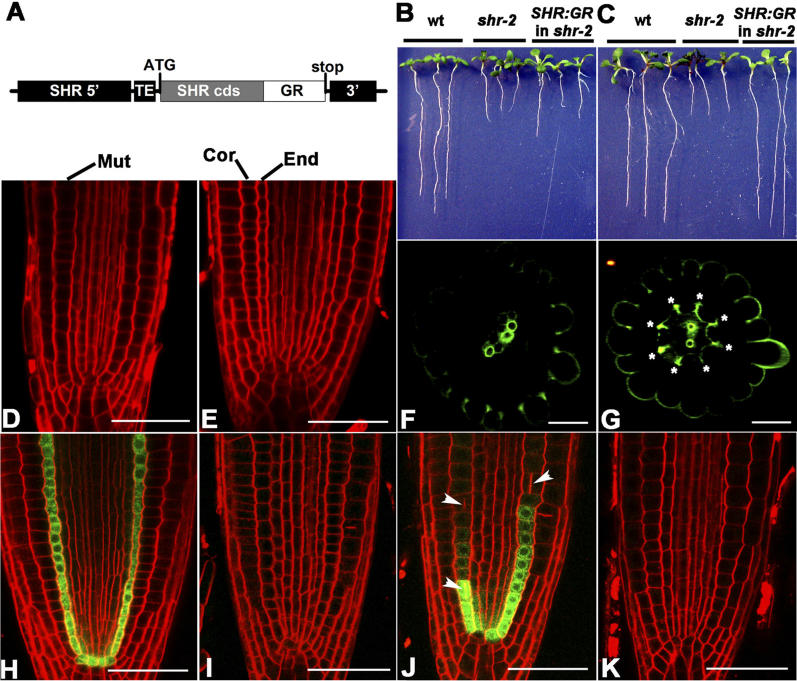
An Inducible Form of SHR Rescues Root Growth and Radial Patterning Defects in the
shr Mutant
(A) Structure of the
pSHR::SHR:GR gene construct. DNA fragments are not drawn to scale. SHR 5′, 2.5-kb SHR 5′ upstream sequence; TE, tobacco etch virus translational enhancer sequence; SHR cds, SHR coding sequence; GR, steroid-binding domain sequence of the rat GR; 3′, nopaline synthase polyadenylation sequence.
(B and C) Wild-type,
shr-2, and
shr-2 pSHR::SHR:GR 5-d-old seedlings germinated on a medium either without (B) or with (C) 10 μM Dex.
(D and E) Confocal section of roots from 5-d-old
shr-2 pSHR::SHR:GR plants germinated on a medium either without (D) or with (E) 10 μM Dex. Cor, cortex; End, endodermis; Mut, mutant.
(F and G) JIM13 antibody staining of root transverse section from 5-d-old
shr-2 pSHR::SHR:GR plants germinated on a medium either without (F) or with (G) 10 μM Dex. The stars indicate restoration of JIM13 staining in the ground tissue.
(H–K)
pSCR::GFP expression in roots of 5-d-old plants germinated on medium containing Dex and/or Cyc. (H) Root from untreated wild-type. (I) Root from untreated
shr-2 pSHR::SHR:GR plants. (J) Root from
shr-2 pSHR::SHR:GR plants treated with 10 μM Dex. The arrows indicate asymmetric cell divisions induced in response to the Dex treatment. (K) Root from
shr-2 pSHR::SHR:GR plants treated with 10 μM Dex and 10 μM Cyc.
Scale bars: 25 μm.